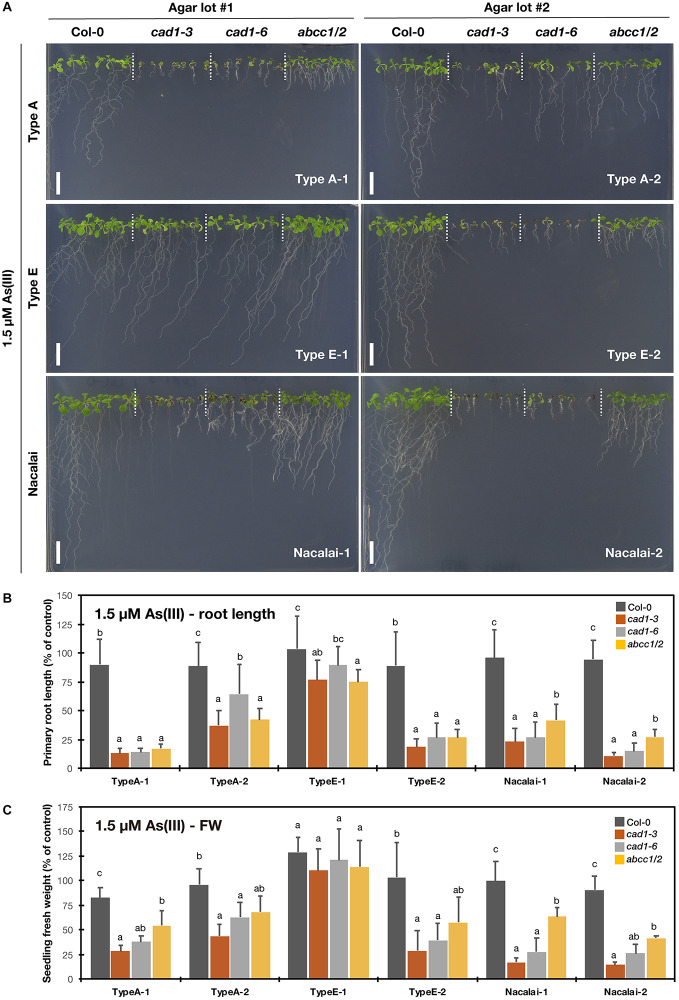
As(III)-sensitivity of the phytochelatin-related Arabidopsis mutants on the agar plates prepared with different agar reagents. Three types of agar reagents with two independent lots for each type were tested. Col-0, cad1-3, cad1-6 and abcc1/2 were grown on the agar medium containing 1.5 μM As(III) for 12 days. (A) Phenotypes of Col-0, cad1-3, cad1-6, and abcc1/2. Scale bars = 1 cm. (B,C) Relative primary root length (B) and fresh weight of seedlings (C) of Col-0, cad1-3, cad1-6, and abcc1/2. Values are shown as percentage of each control. Data represent means with SD from at least three independent experiments (n = 19 – 28 for root length, and n = 3–4 for seedling fresh weight). Means sharing the same letter are not significantly different within each agar reagent (P < 0.05, Tukey’s HSD).